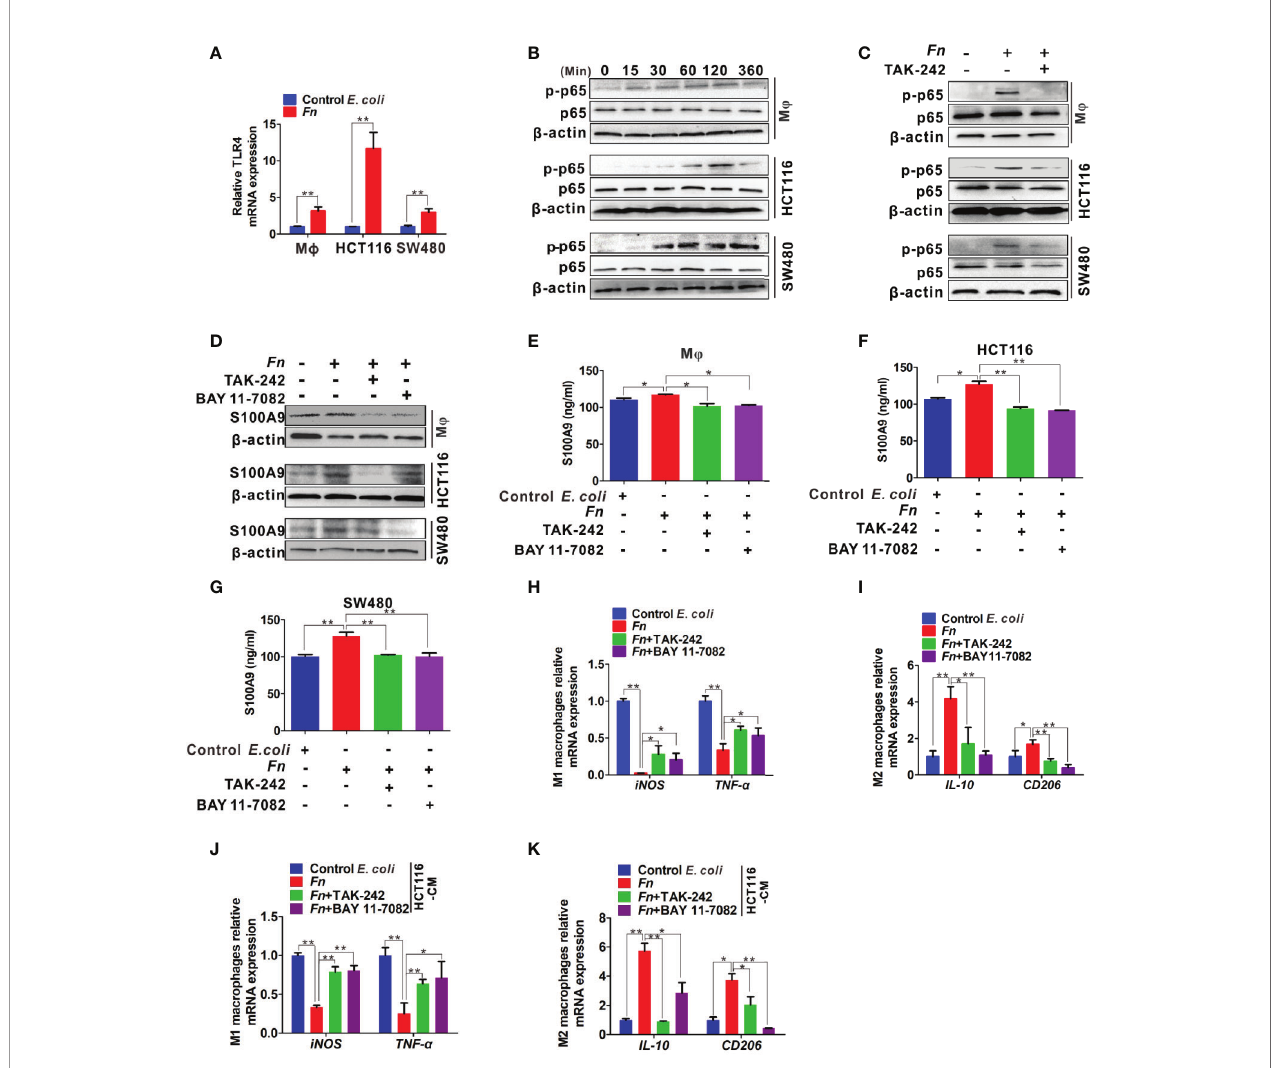
FIGURE 5 | Expression of S100A9 and M2-like M j polarization is regulated by TLR4/NF- k B activation caused by Fn . (A) qPCR analysis of TLR4 expression in M j and CRC cells co-cultured with control E. coli or Fn for 48 h. (B) Western blot analysis of p65 and p-p65 expression in M j and CRC cells co-cultured with Fn for 0,15, 30, 60, 120 and 360 min. (C) Western blot analysis of p-p65 level in M j and CRC cells pretreated with or without inhibitor TAK-242 for 60 min and then co- cultured with control E. coli or Fn for 120 min. (D) Western blot analysis of S100A9 level in M j and CRC cells pretreated with or without inhibitors TAK-242 and NF- k B for 60 min and then co-cultured with control E. coli or Fn for 48 h. (E – G) ELISA analysis of S100A9 level in the CM of M j and CRC cells pretreated with or without inhibitors TAK-242 and Bay 11-7082 for 60 min and then co-cultured with control E. coli or Fn for 48 h. (H – K) qPCR analysis for mRNA levels of M1 markers (iNOS and TNF- a ) and M2 markers (IL-10 and CD206) in M j . The cells were pretreated with or without inhibitors TAK-242 and Bay 11-7082 for 60 min and then co-cultured with control E. coli or Fn for 24 h (H, I) or co-cultured with the CM of HCT116 cells for 24 h (J, K) . The CM of HCT116 cells were pretreated with or without inhibitors TAK-242 and Bay 11-7082 for 60 min and then co-cultured with control E. coli or Fn for 48 h. Data were expressed as means ± SD in three independent experiments. *p < 0.05, **p <